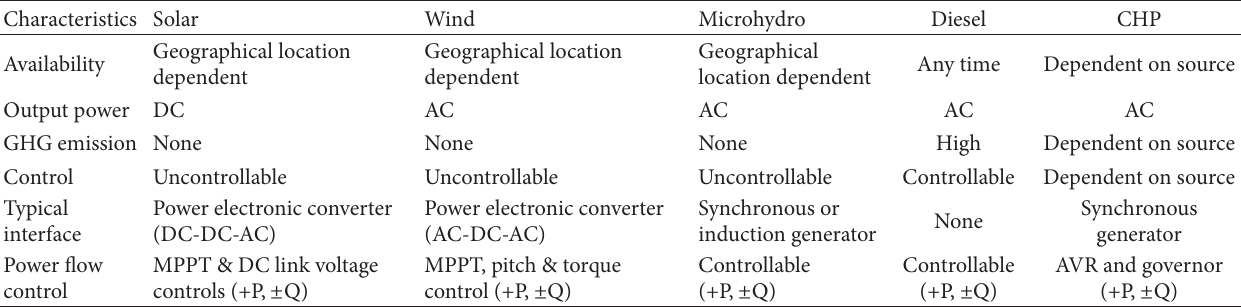
Table 1: Typical characteristics of common DG sources [5,